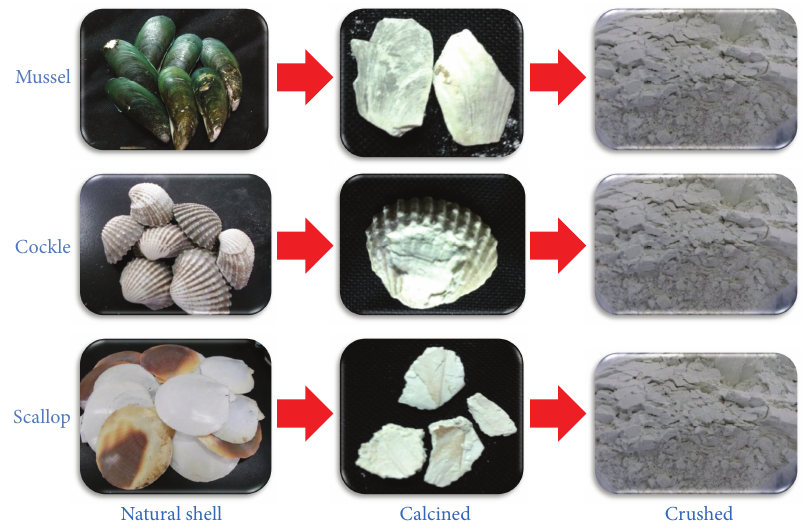
Figure 1: Preparation of CaO catalyst derived from waste shell (1,000 ∘